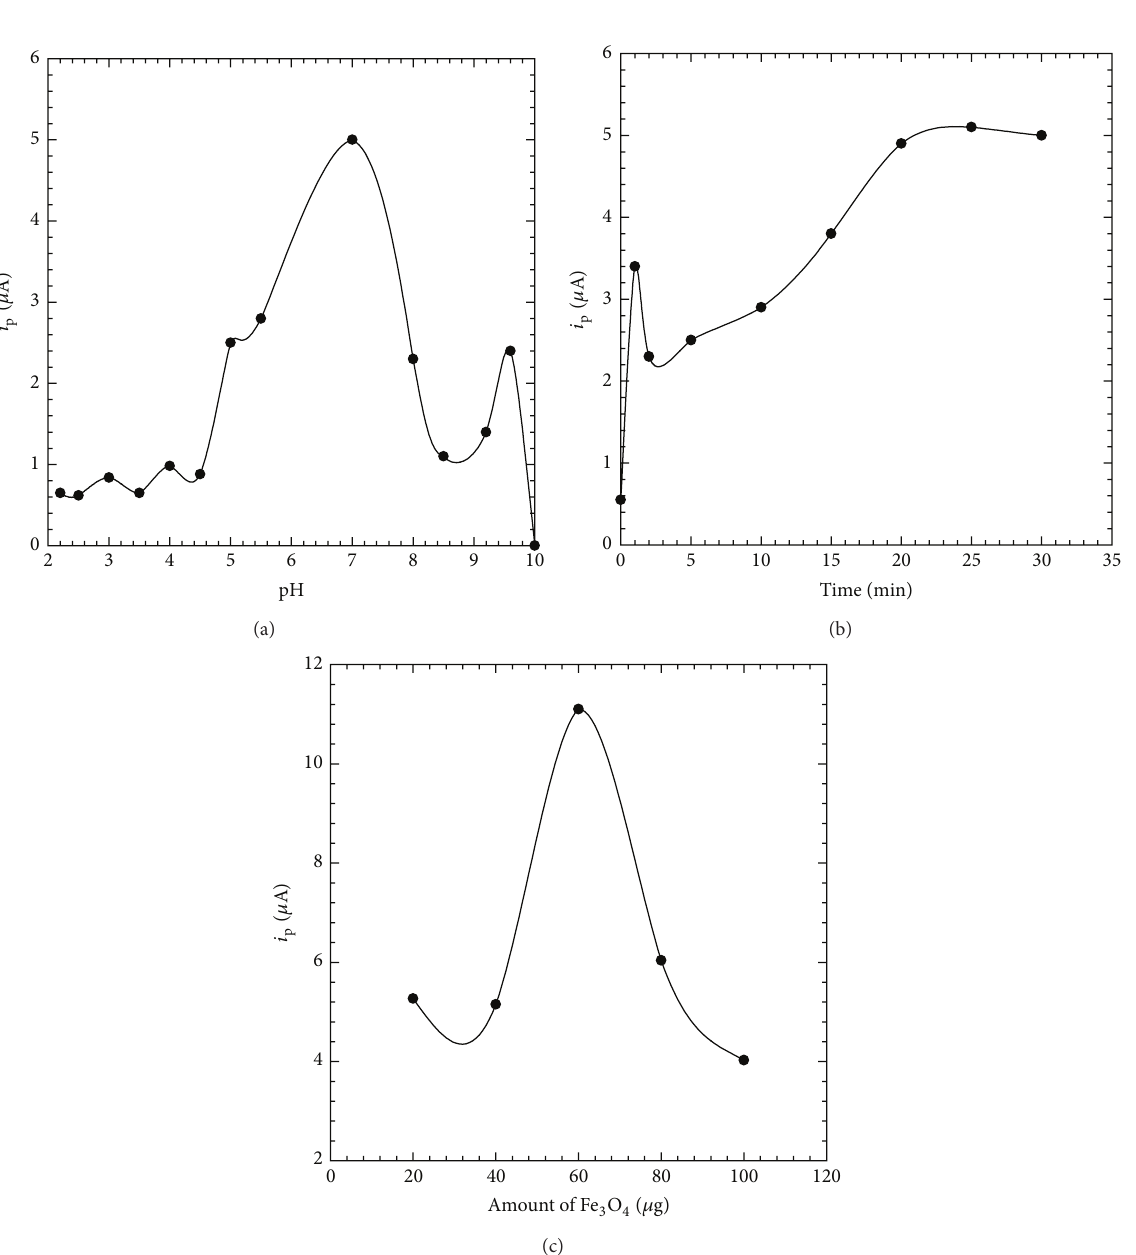
Figure 7: Response of the MCPE/MNP as a function of (a) pH, (b) pre-concentration time, and (c) amount of MNPs. Pre-concentration conditions: PBS (pH 7.0) containing 5.0 × 10 −5 M DA at the open-circuit potential. Measurement conditions, SWV in PBS, DA free, pH 7.0, and 0.1M NaClO 4